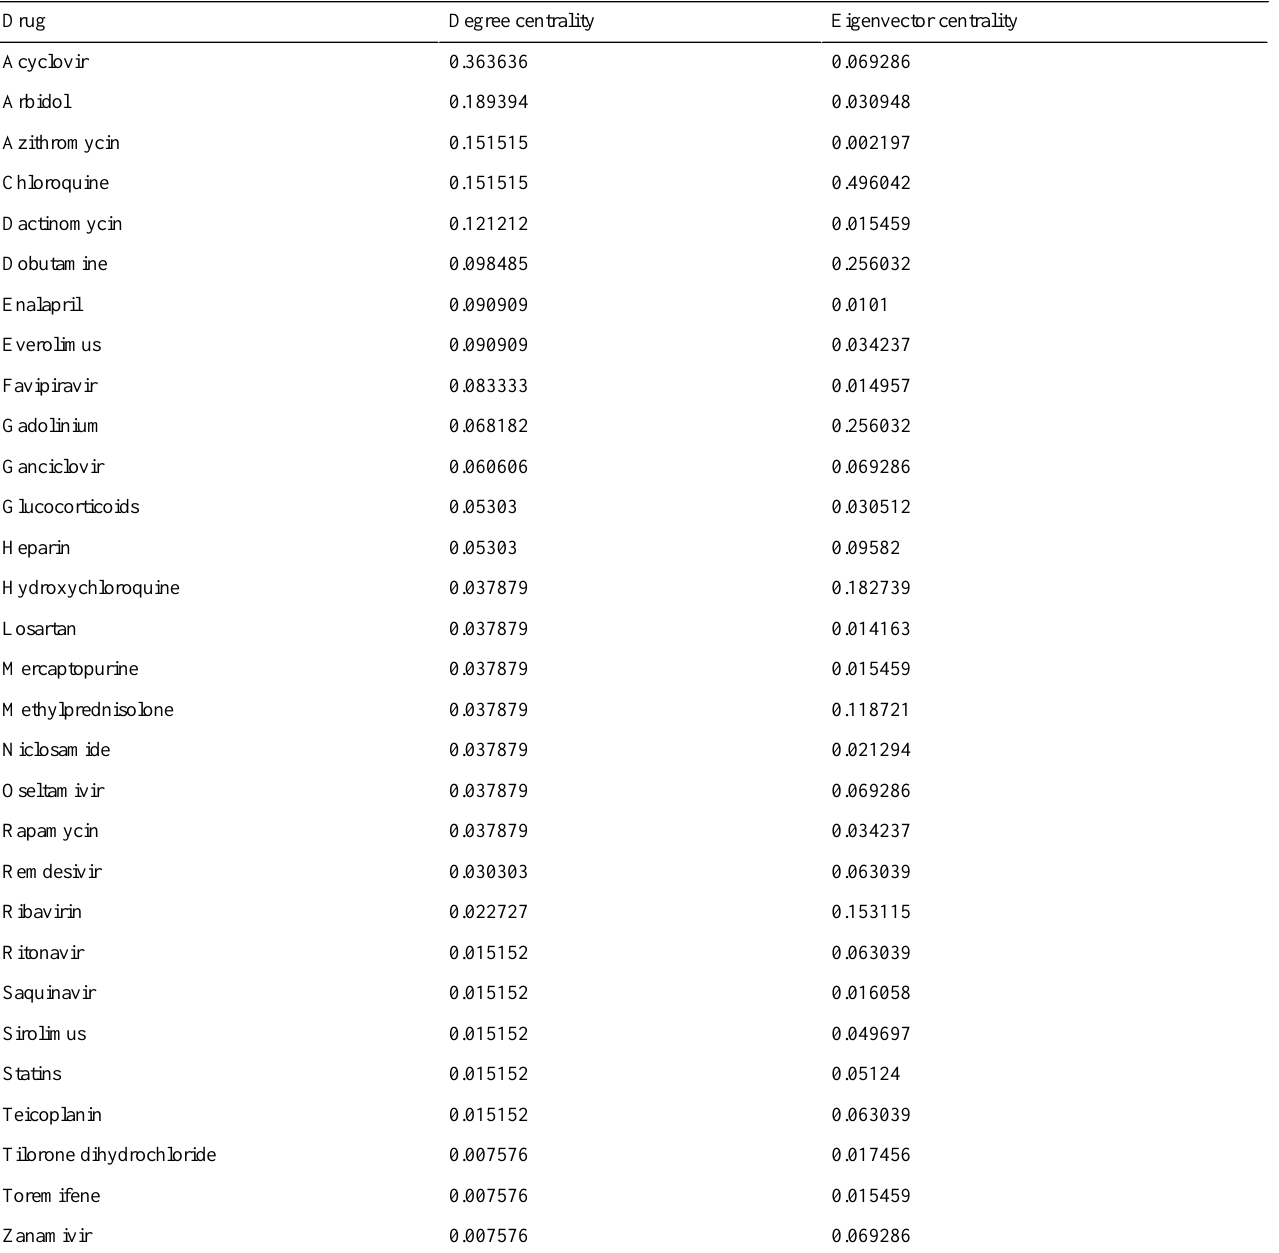
Table 2. Summary of the network centrality